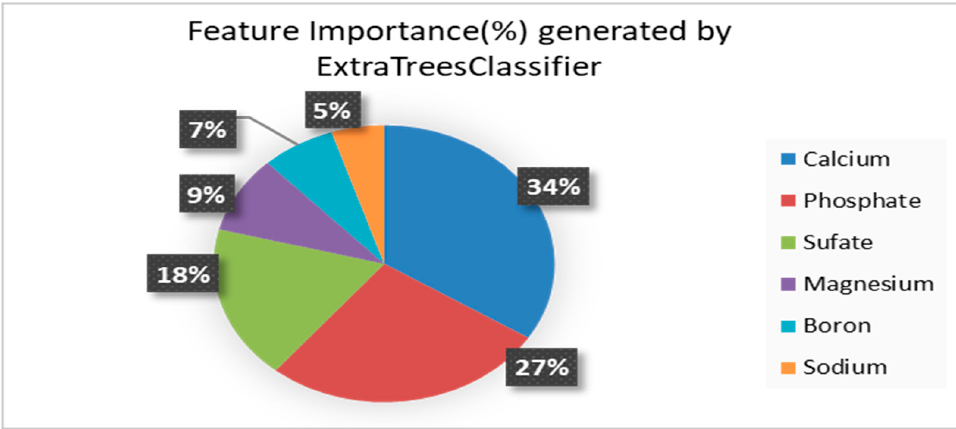
Figure 6. Feature Importance of the predictors generated by the ExtraTreesClassifier.